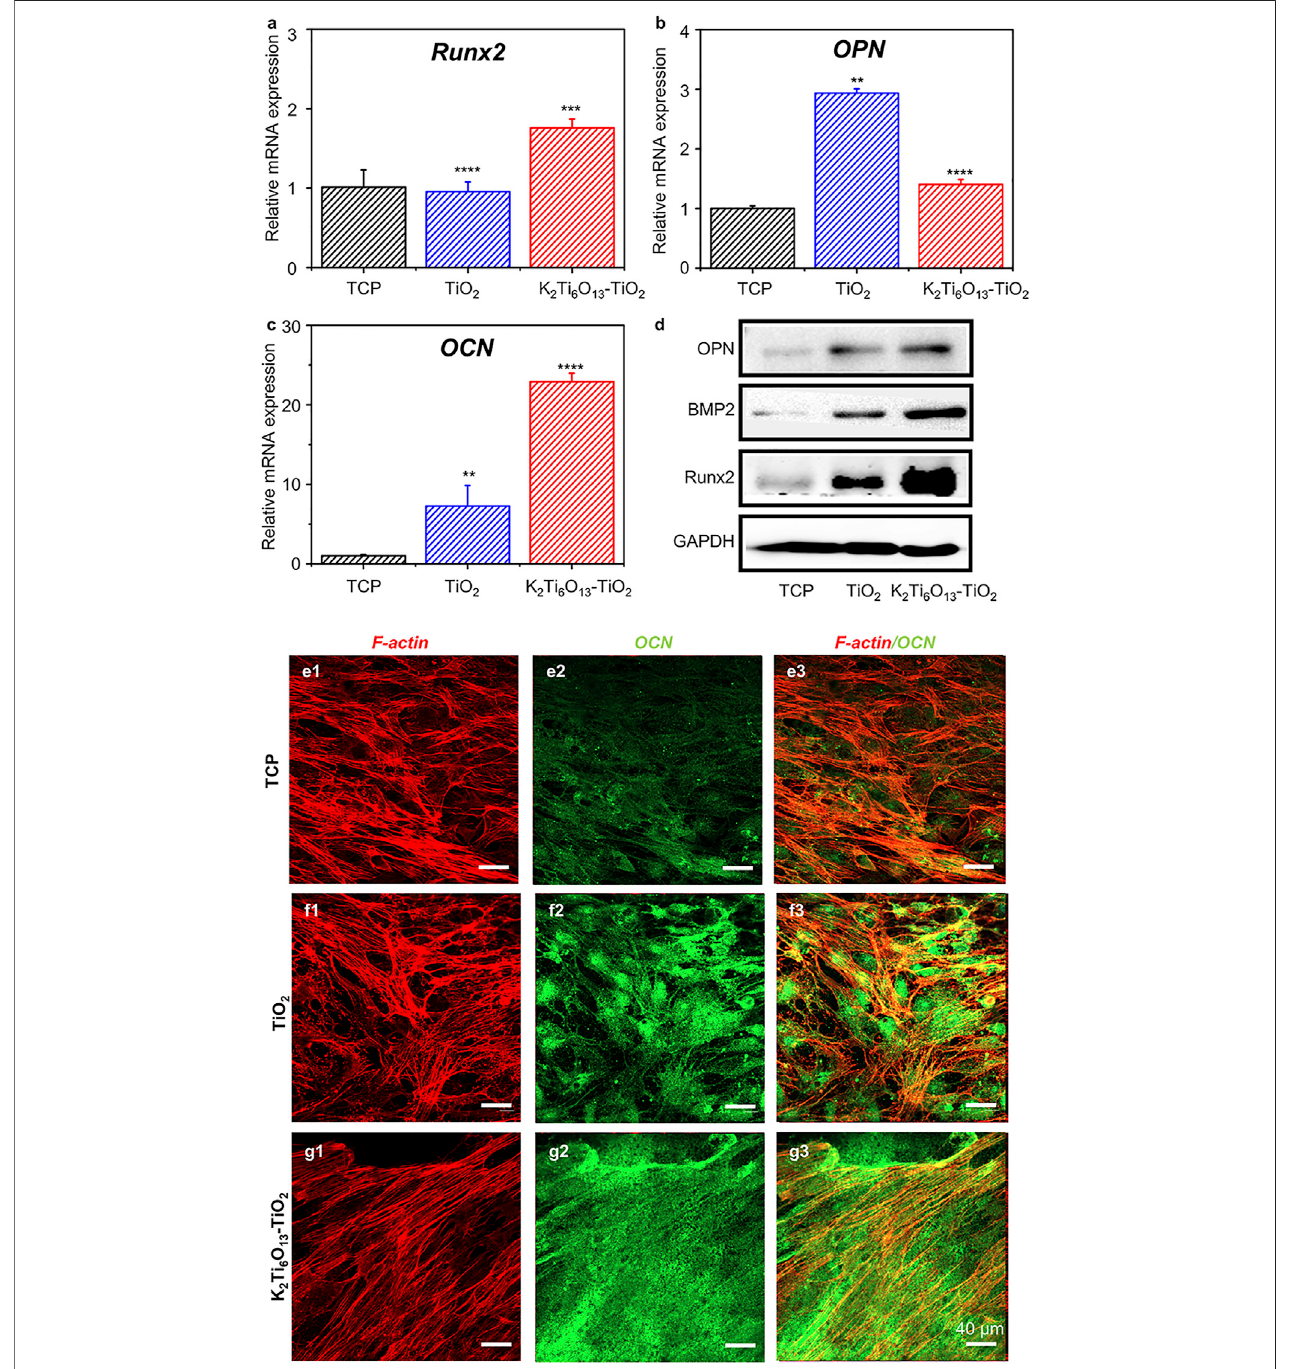
FIGURE 4 | Gene and protein expression of the osteogenic differentiation of MSCs on TiO 2 nanotube and K 2 Ti 6 O 13 -TiO 2 hybrid nanorod arrays for 14 days. Osteogenic-related mRNA expressions of (A) Runx2, (B) OPN, and (C) OCN. (D) Western blot images of osteogenic marker, OPN, BMP2., Runx2, (E – G) Immuno fl uorescencecellularstainingimagesofthecytoskeleton(red)andOCN(green).Datarepresentthemean±standarddeviation( n =3).*** p < .001comparedwith TCP. Scale bars in (E – G) are 40 μ m.